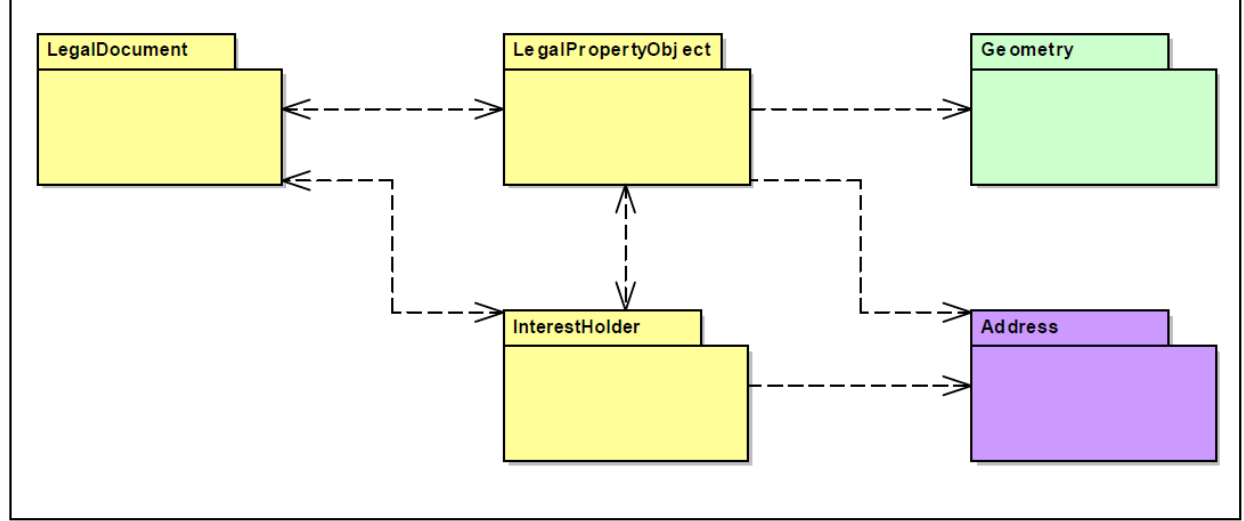
Figure 4. LegalPropertyObject’s package view, adopted from [25].